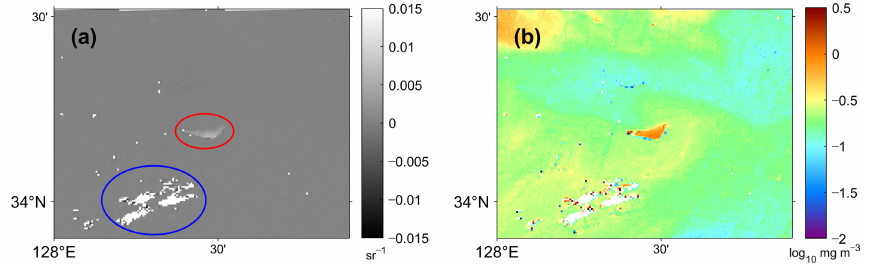
Figure 6. Example of failure in cloud detection in the ( a ) grayscale image of R rs (555) and ( b ) chlorophyll- a concentration image on 3 June